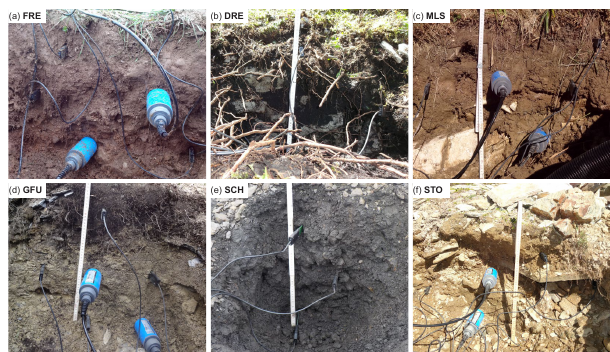
Figure 3. Illustration of the soil characteristics and sensor installa- tion for all SOMOMOUNT